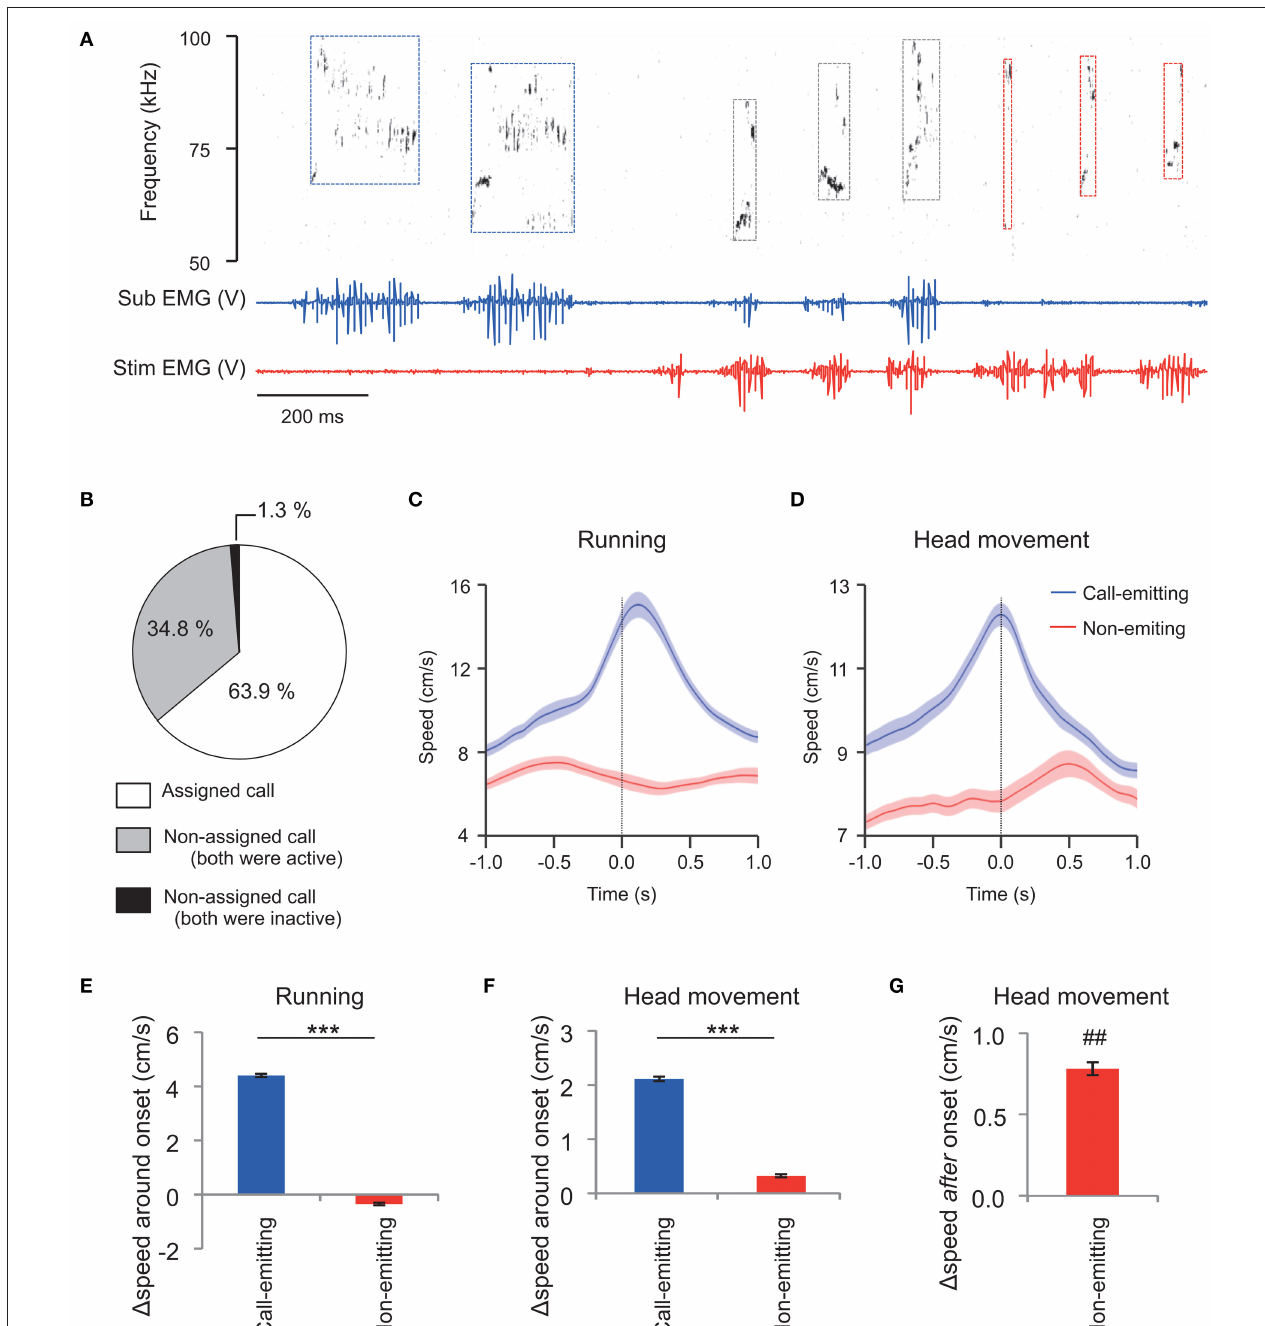
FIGURE 3 | Assignment of WFM calls during social interactions between vocalizing male rats (M sessions). (A) An example of call assignment. Simultaneously recorded sonogram (top), TA EMG of a subject rat (middle), and TA EMG of a stimulus conspecific (bottom) are shown. Each rectangle demarcated by dashed lines in the sonogram represents one call and the color of the square represents estimated source of the call (blue: the subject rat; red: the stimulus rat; black: indistinguishable) based on the concurrent TA EMG. Sub: subject; Stim: stimulus rat. (B) Distribution of call assignments. (C,D) Averaged (horizontal plane) speeds measured from the trunks (C) of and the head (translation) relative to the trunk (D) . Speeds are shown for the call-emitting (blue) and non-emitting (red) rats. The solid lines and translucent areas indicate the means and SEMs, respectively. Time zero represents the onset of the calls. (E,F) The change in trunk speed in horizontal plane and head movement relative to the trunk around the onset of WFM calls [ 1 speed around onset = (mean speed during the first 0.5s after call onset) − (mean speed at − 1.0 to − 0.5s prior to call onset)] of either the call-emitting (blue) or non-emitting (red) rats. (*** indicates p < 0.001, paired t -test). (G) The change in head movement relative to trunk after the onset of WFM calls [ 1 speed after onset = (mean speed at 0.35–0.45s after call onset) − (mean speed at − 0.1–0.0s prior to call onset)] of the non-emitting rats. (## signifies p < 0.01, one-sample t -test).